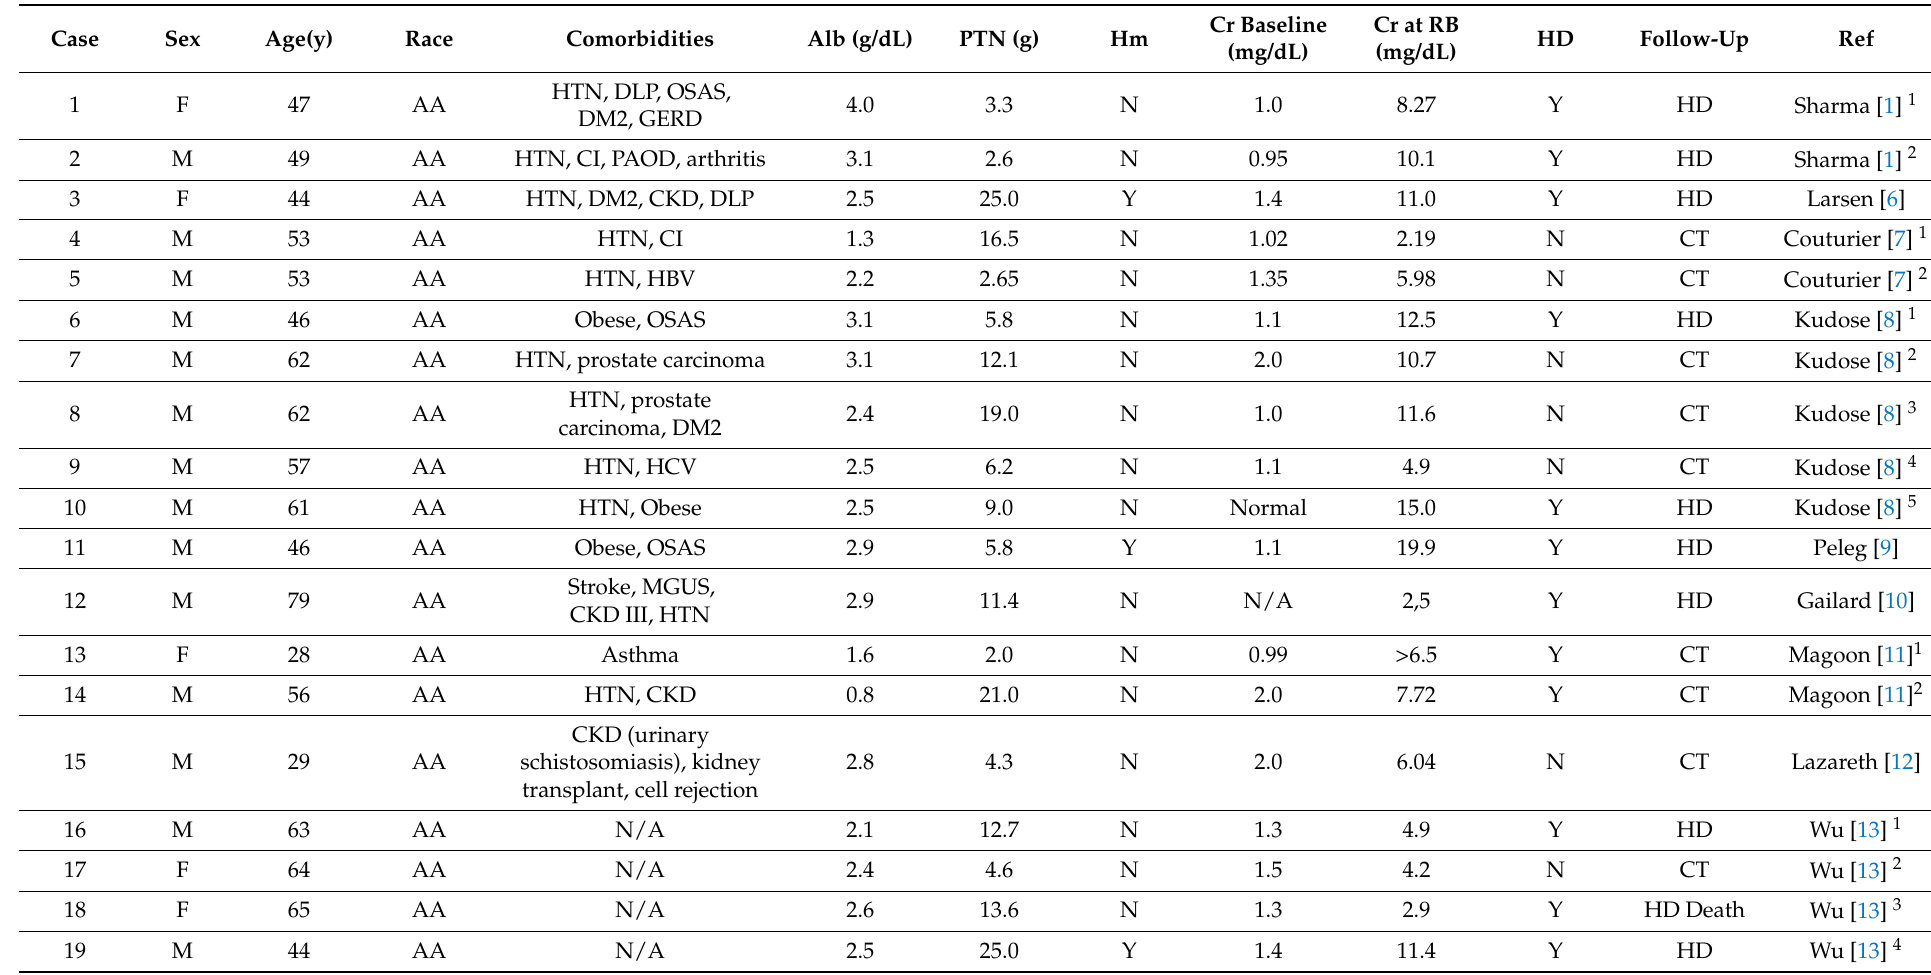
Table 1. Clinical, laboratory findings and follow-up information in published patients with collapsing segmental and focal glomerulosclerosis during COVID-19 infection.